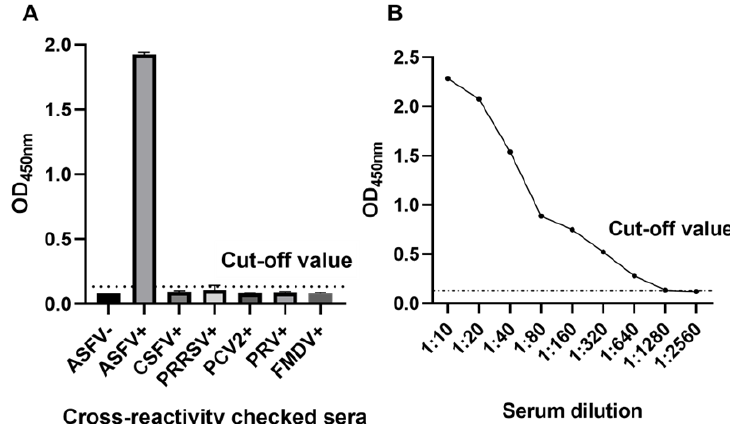
Figure 6. Sensitivity and specificity of the DAgS-ELISA. ( A ): Specificity test of the DAgS-ELISA. The DAgS-ELISA detected no cross-reactions with sera containing antibodies against five other porcine pathogens, including CSFV, PRRSV, PCV2, PRV, and FMDV; ( B ): Sensitivity of the DAgS-ELISA.